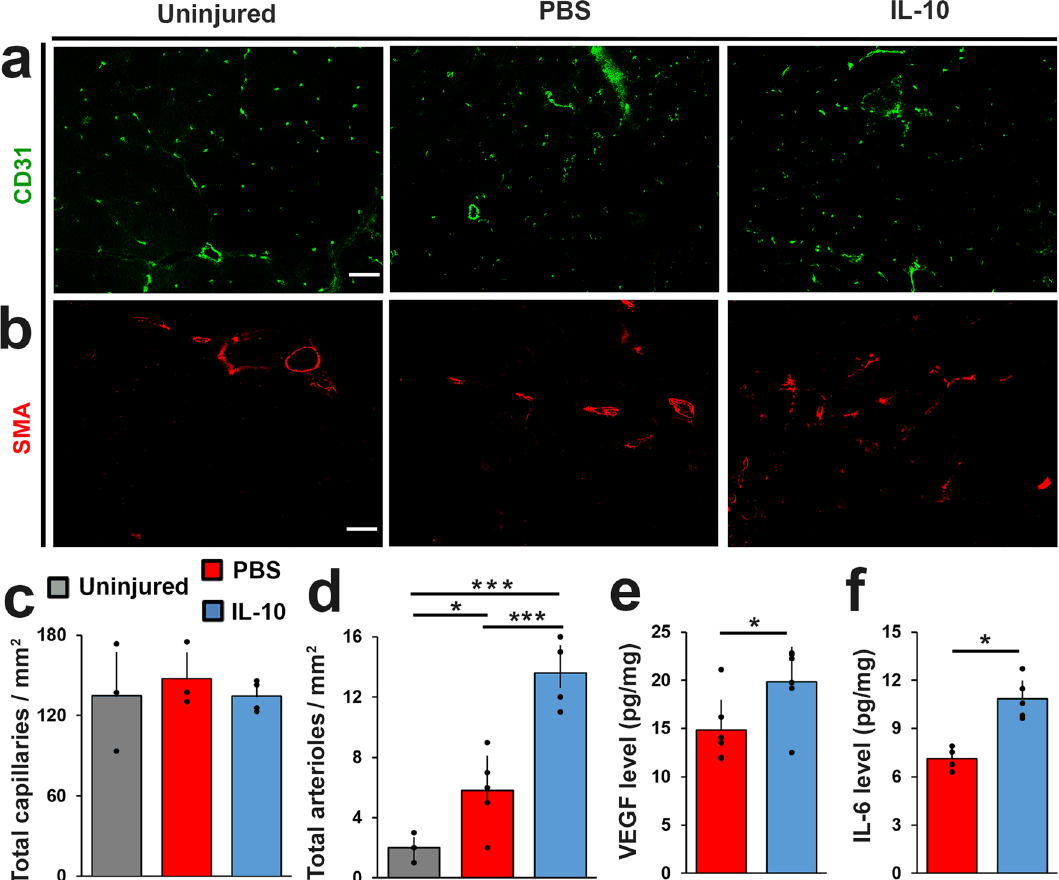
Figure 6. IL-10 promoted repair site arteriole formation . TA muscle cross-sections prepared from 56 DPI were individually stained for ( a ) CD31 (green) or ( b ) α-SMA (red). Scale bar = 100 µm. Immuno-stained tissue cross sections prepared from 56 DPI tissue samples were quantified to determine ( c ) capillary density (capillaries/ mm 2 ), and ( d ) arteriole density (arterioles/mm 2 ). ( e ) VEGF and ( f ) IL-6 concentrations (pg/mg) were measured from 14 DPI tissue samples using multiplex ELISA. Group means + SD are presented; n = 4–5/group. The *, **, and *** indicate statistically significant difference of p < 0.05, p < 0.01, and p < 0.001 between